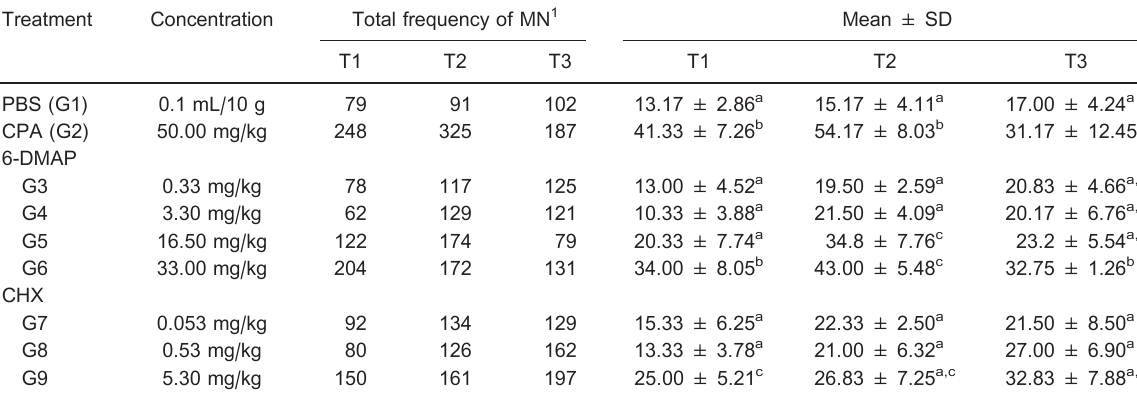
Table 5. Frequency of micronuclei in the peripheral blood of mice. Treatment